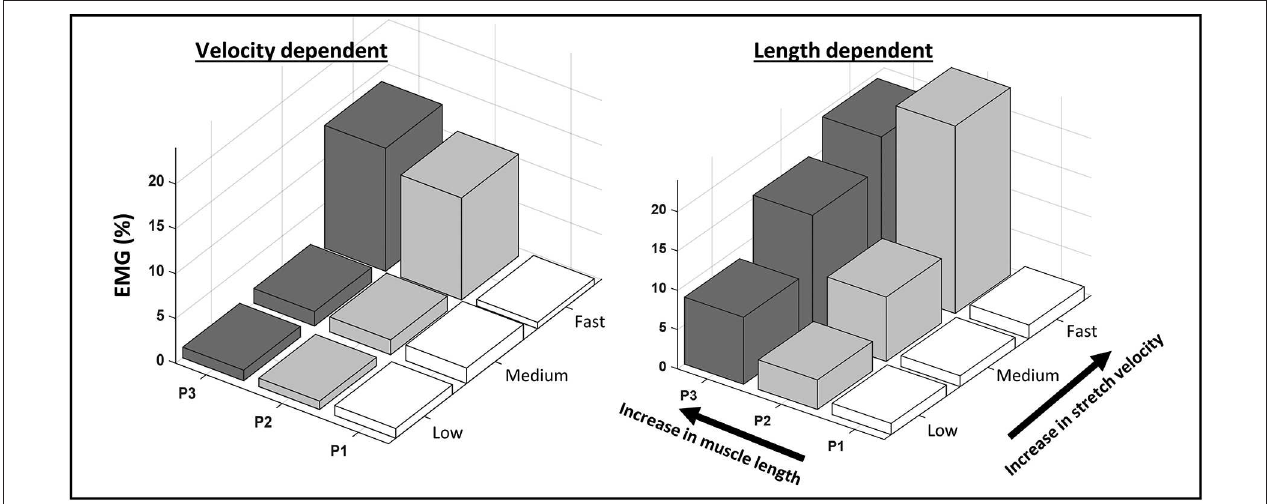
FIGURE 1 | Examples of velocity- and length-dependence of the stretch reflexes in the semitendinosus. The average normalized EMG envelope collected from the semitendinosus during passive knee extensions is shown across equally spaced zones of the range of motion (P1-3) at low, medium and fast stretch velocities. In the velocity-dependent activation pattern, EMG increases with increasing stretch velocity, but not across position zones. In the length-dependent activation pattern, EMG increases with stretch velocity and across position